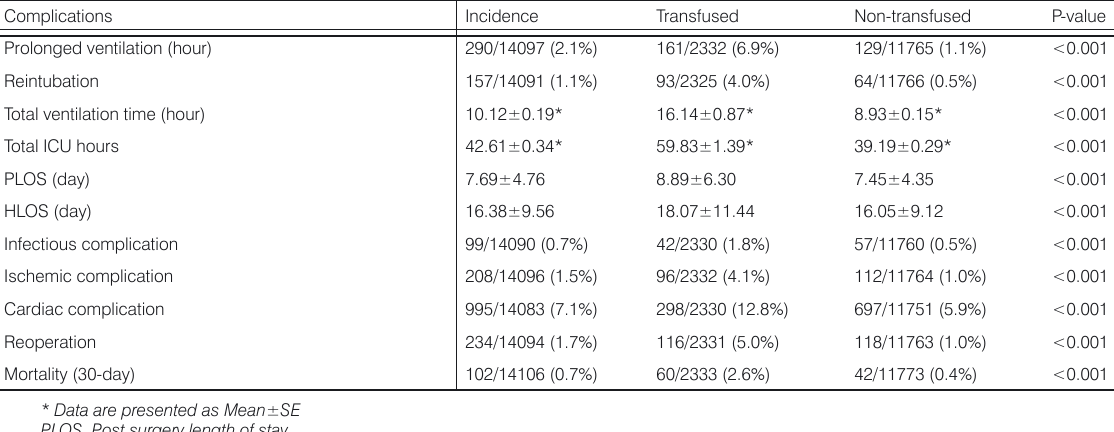
Table 2. Postoperative complications and resource utilization of patients underwent isolated CABG.